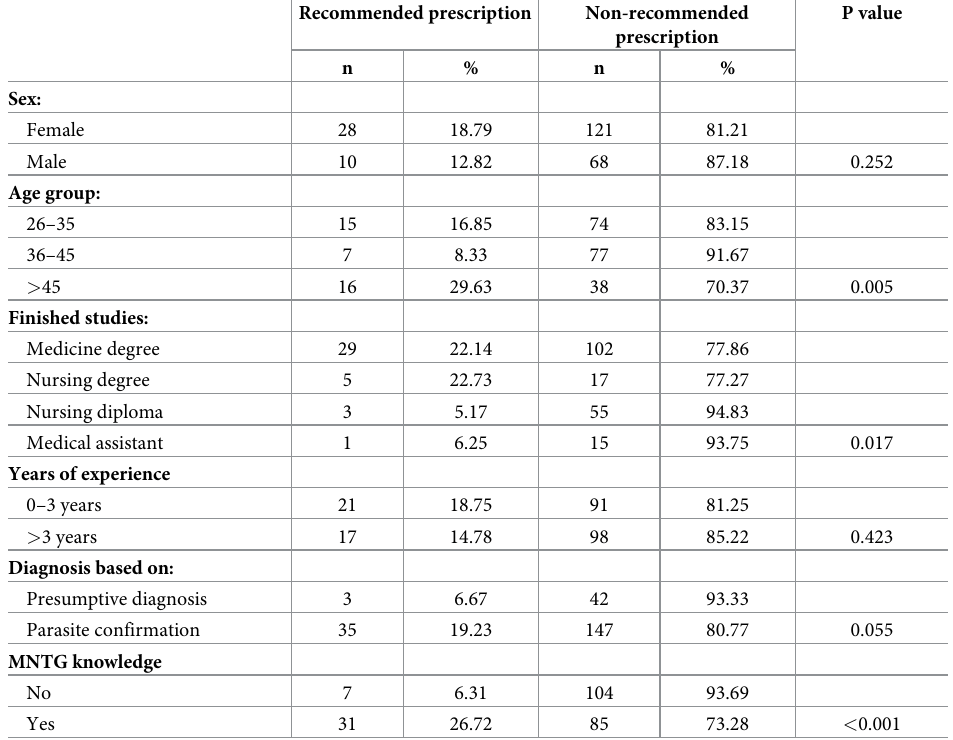
Table 3. Compliance with the MNTG related to practitioner characteristics and practices.